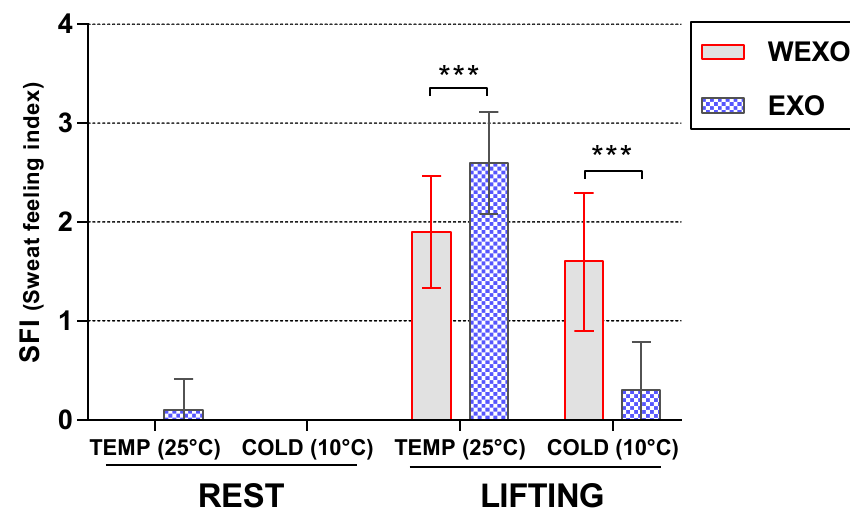
Figure 9. Sweat feeling index under WEXO and EXO (*** p < 0.001).